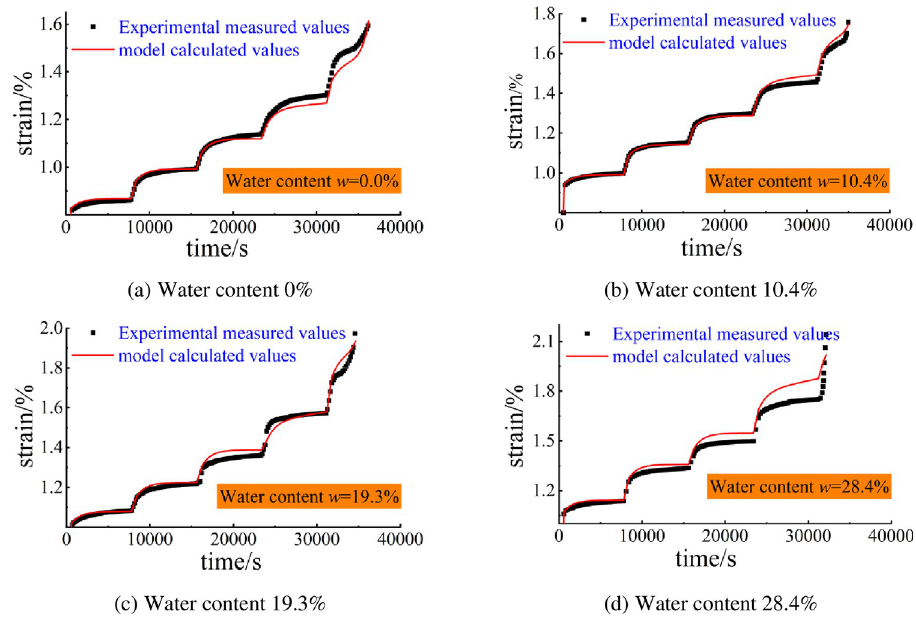
Fig 10. Ageing creep model with water; comparison of calculated and measured values. (a) Water content 0%, (b) Water content 10.4%, (c) Water content 19.3%, (d) Water content